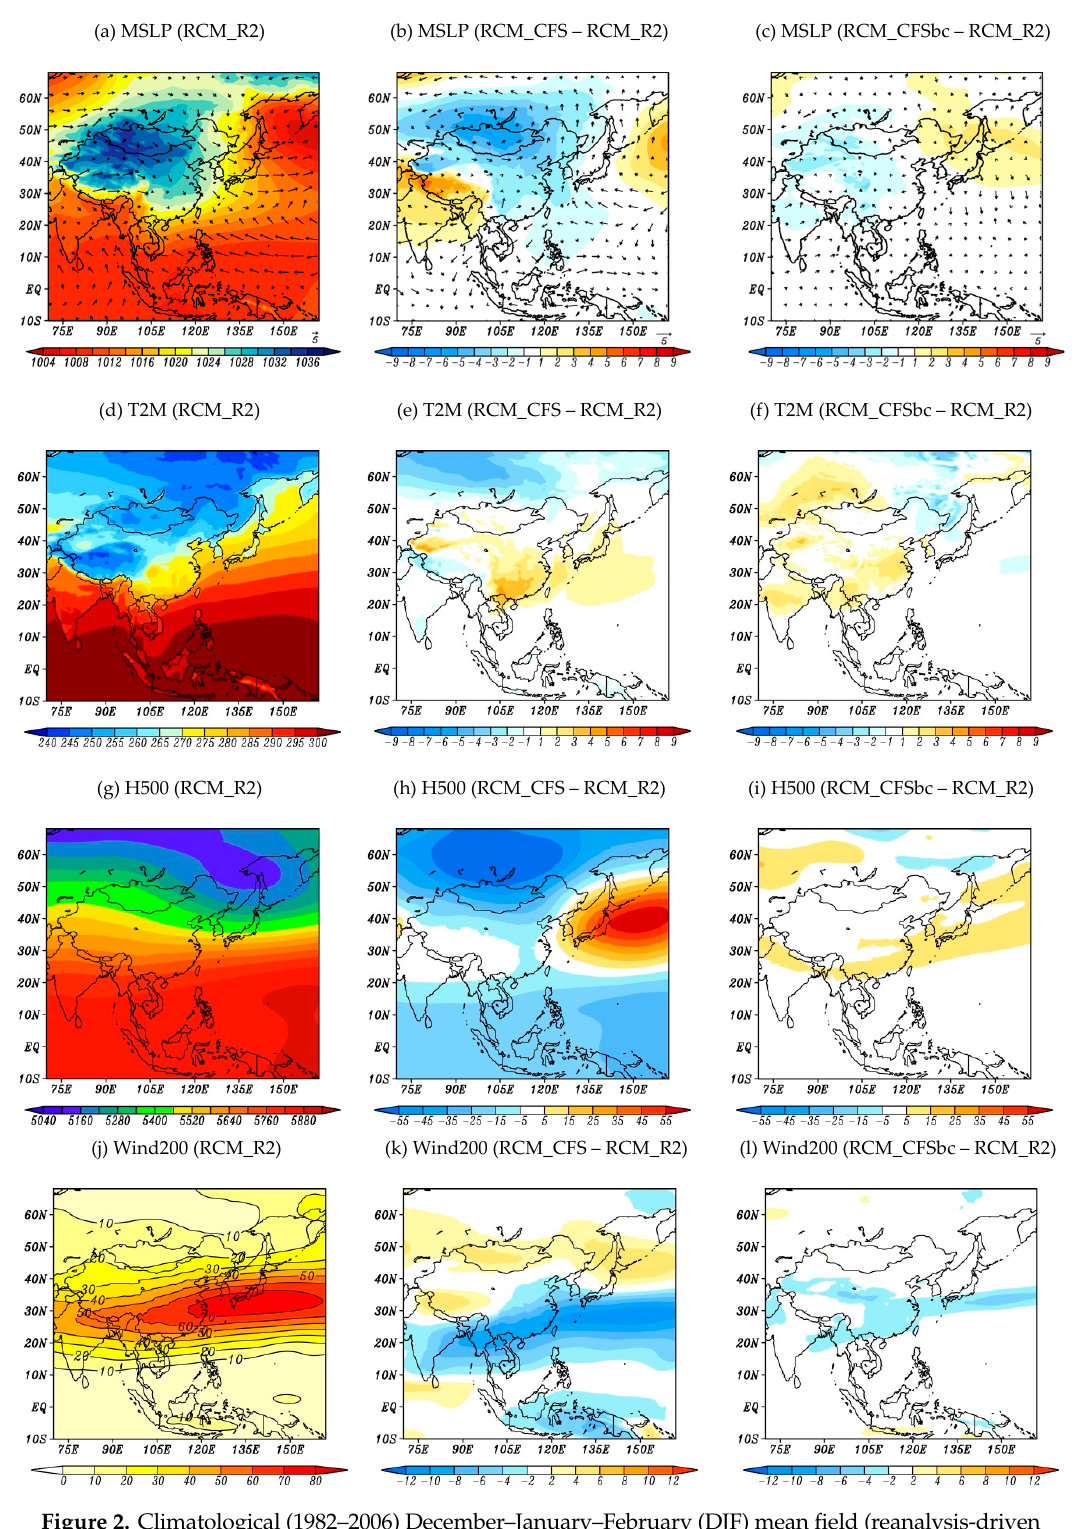
Figure 2. Climatological (1982–2006) December–January–February (DJF) mean field (reanalysis-driven (RCM_R2), left) and difference between reanalysis-driven (RCM_R2) and RCM_CFS (RCM_CFS–RCM_R2, center), RCM_CFSbc (RCM_CFSbc–RCM_R2, right) for ( a )–( c ) mean sea level pressure (hPa; shaded) and 850 hPa wind (m/s; vector), ( d )–( f ) 2 m temperature (K), ( g )–( i ) 500 hPa geopotential height (gpm), and ( j )–( l ) 200 hPa wind magnitude (m/s).